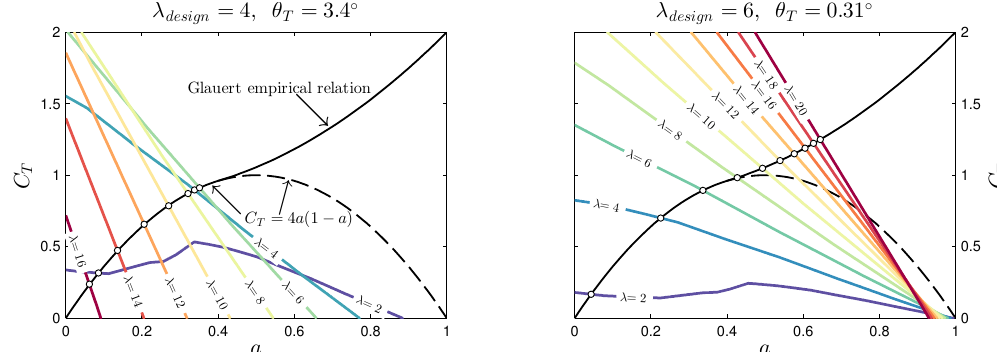
Figure 5. Variation of the thrust coefficient C T with the normal induction factor a for an annulus at two different design tip-speed ratios ( λ design = 4 and 6). The airfoil profile is NACA0012, operating at Re c = 1.76 × 10 6 . The black lines represent the relationship based on the momentum approach, while the colored lines show it from the blade-element approach. For each tip-speed ratio, the operating condition is indicated by hollow white